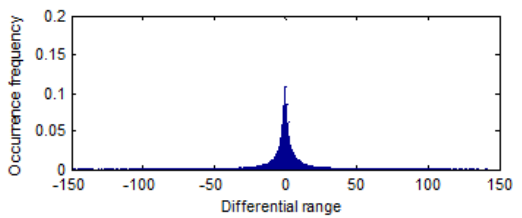
Figure 4. The order difference value distribution of the Lena.jpg.